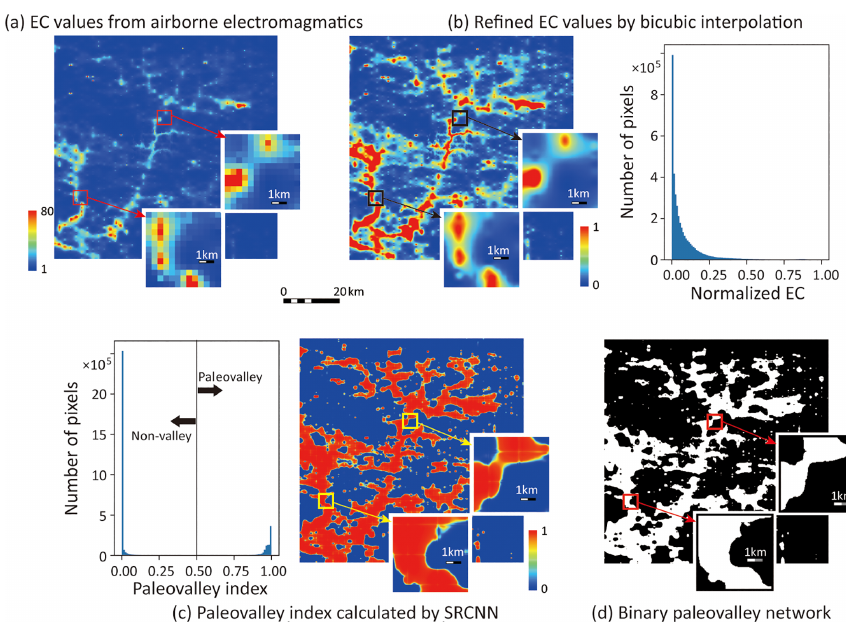
Figure 8. Steps to derive a binary paleovalley network in an 80km × 80km region in APY lands, Australia. (a) Raw EC map at a depth of 100m; (b) EC map after bicubic interpolation; (c) paleovalley channel index map after application of the trained SRCNN method; (d) binary paleovalley